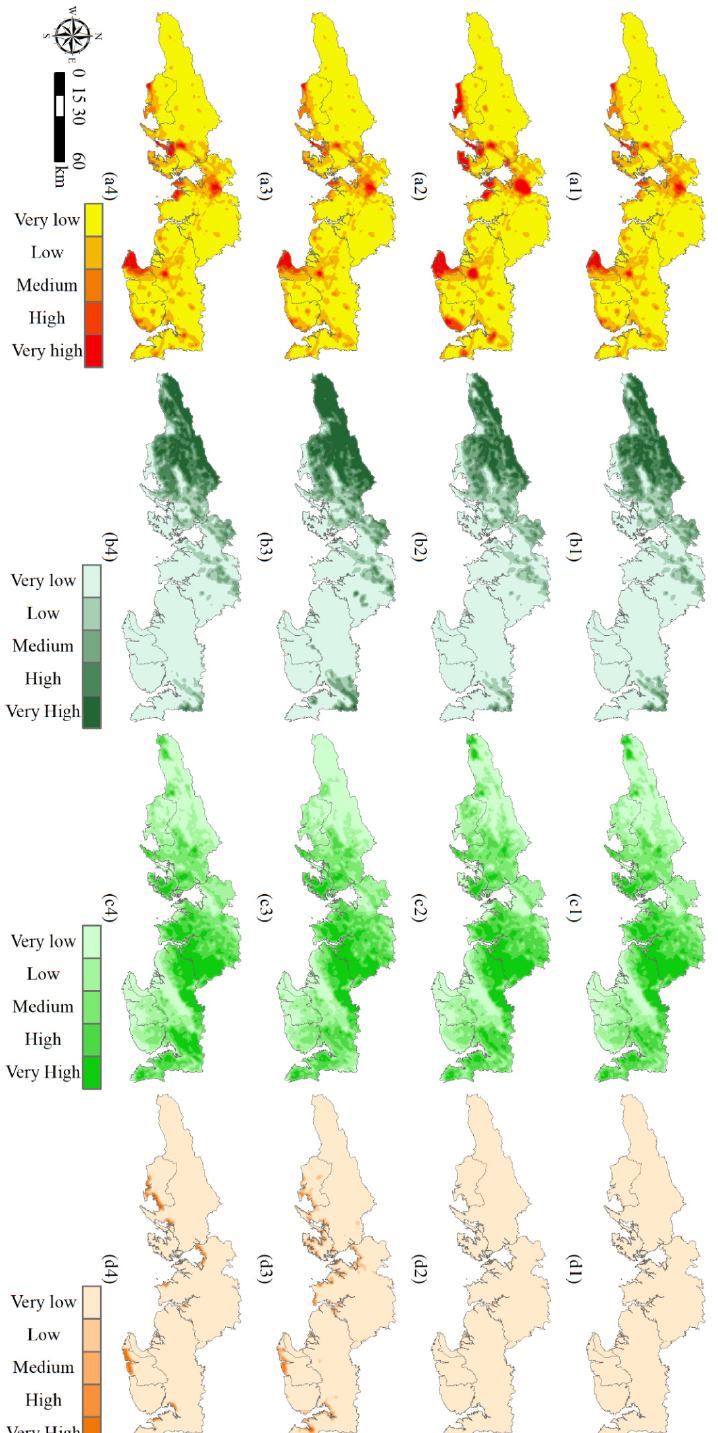
Figure 5. Kernel density analysis of construction land ( a ), forestland ( b ), orchard ( c ), and mud flat ( d ) for the year of 2014 ( 1 ), the regular growth scenario ( 2 ), the ecological protection scenario ( 3 ), and the ecotourism scenario ( 4 ).